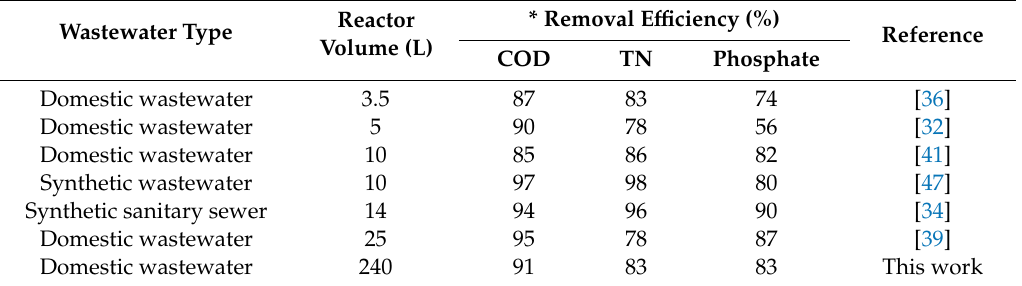
Table 4. Comparison of COD, TN, and phosphorus removal e ffi ciencies with the literature.